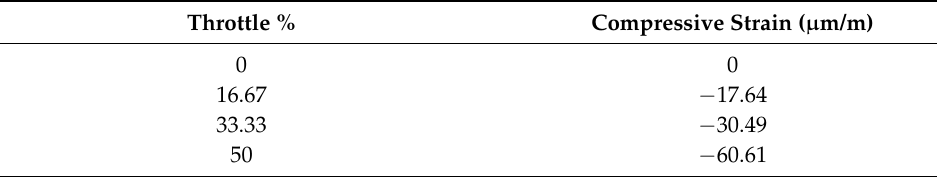
Table 11. Strain induced during hovering at different throttle conditions.